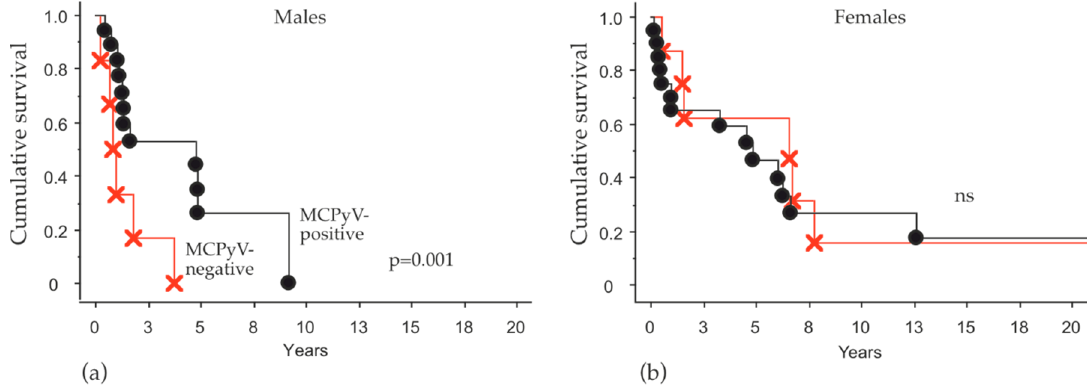
Figure 2. Overall survival analysis in male patients in relation to MCPyV status. Kaplan–Meier plots illustrating overall survival (OS) in ( a ) male and in ( b ) female patients with MCPyV-positive (black) or MCPyV-negative (red) tumor tissue, p = 0.001. Table 3. Hazard ratios by Cox–Mantel regression analysis comparing MCPyV negative vs. posi- tive filtered by sex.